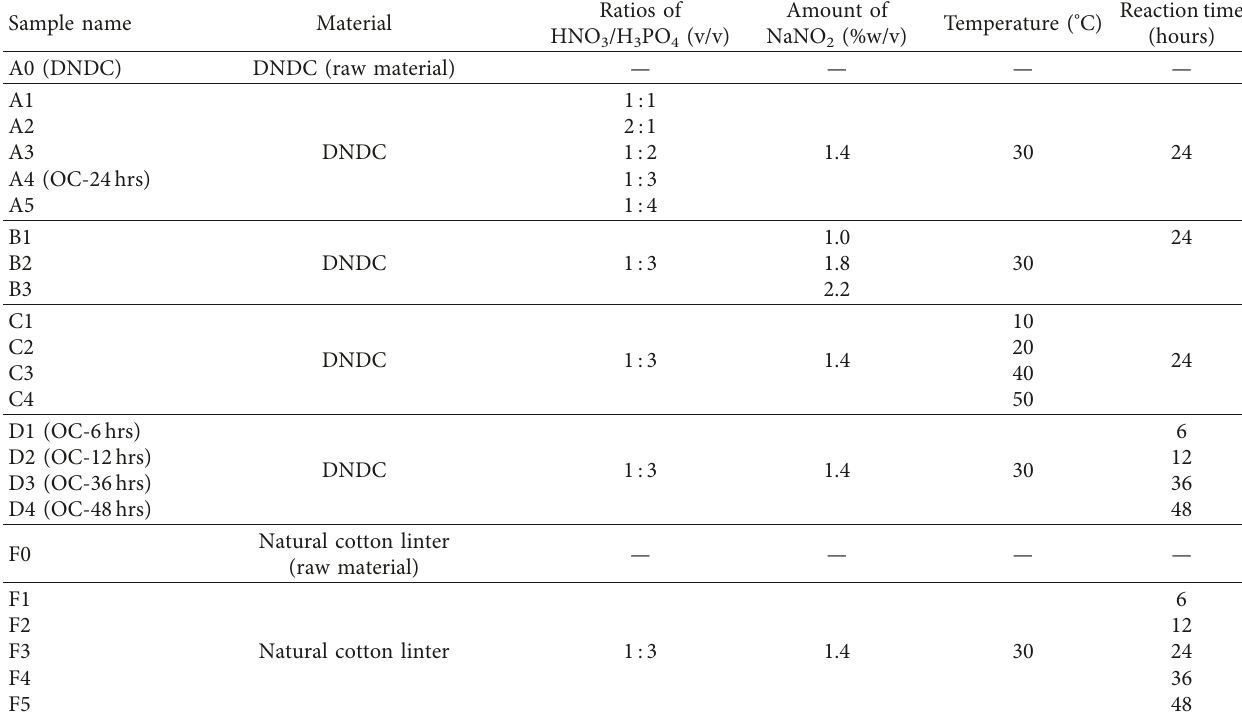
Table 1: The conditions for synthesis of